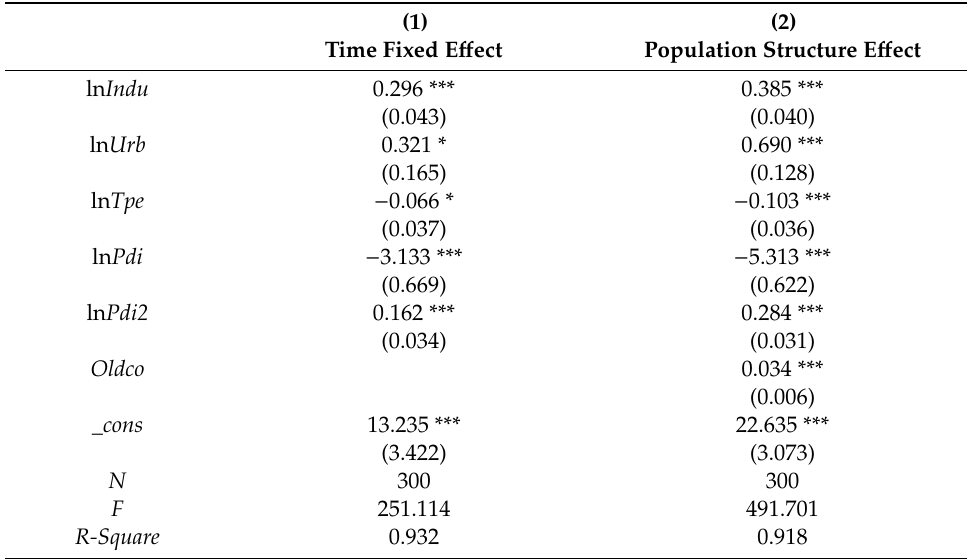
Table 3. Regression results of time e ff ect and age